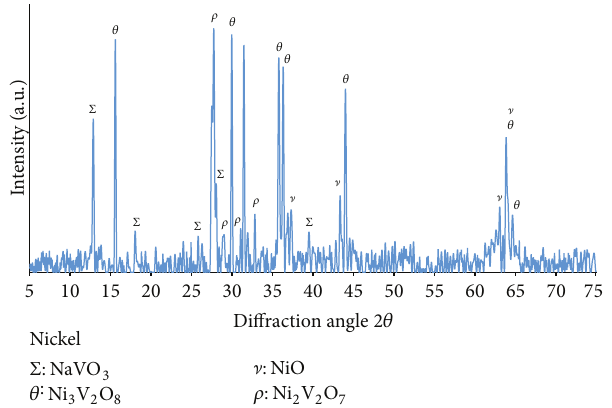
Figure 5: X-ray diffraction results of corrosion products of nickel exposed to NaVO 3 at 700 ∘ C during 100